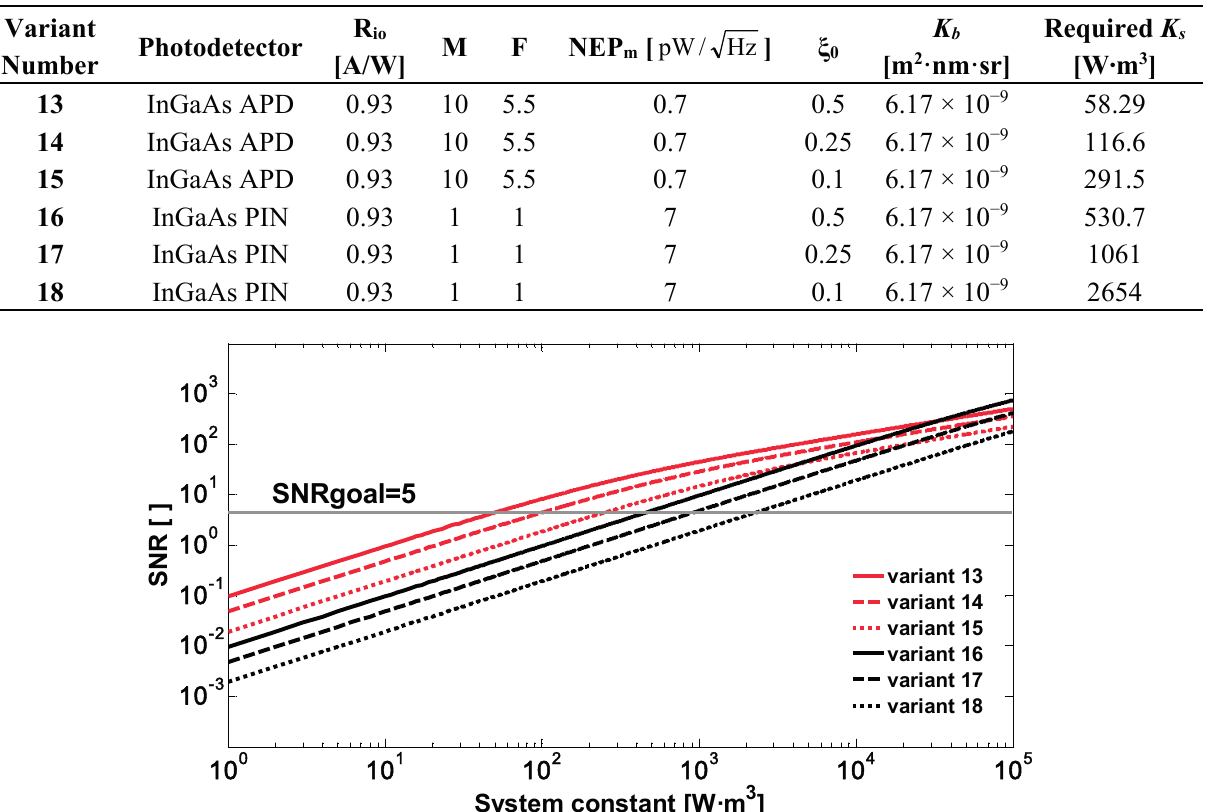
Figure 4. Signal-to-noise ratio vs. system constant due to a spray drift cloud located at 500 m for variants 13 to 18 (Table